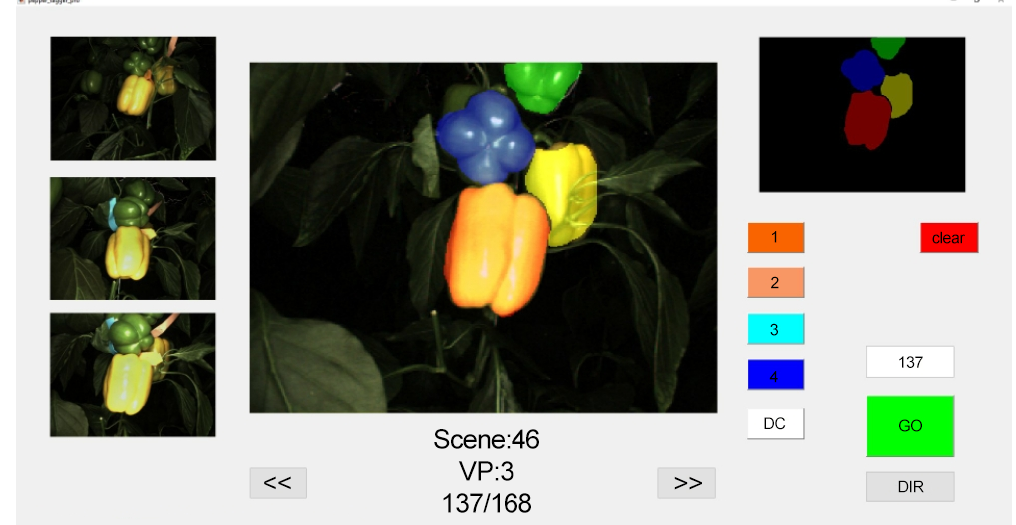
Figure 7. Custom-made user interface developed for labeling database